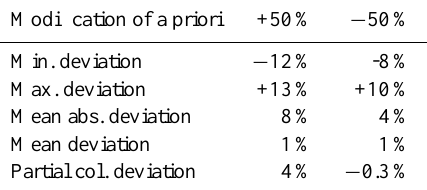
Table 3. Details of the a priori influence experiment, valid for the vertical range of the main sensitivity between 40 and 80km altitude.